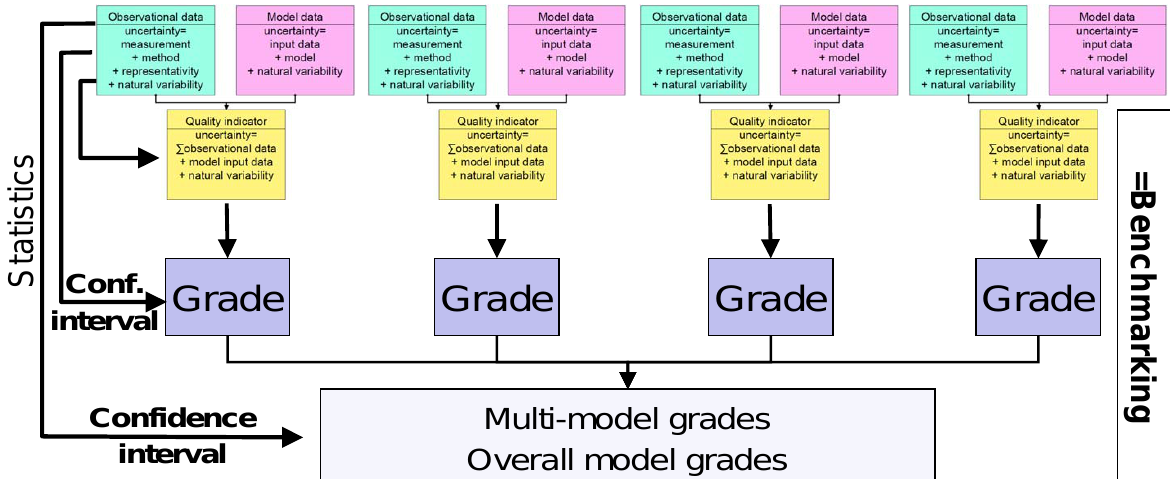
Fig. 4. Overview on the whole benchmarking procedure.